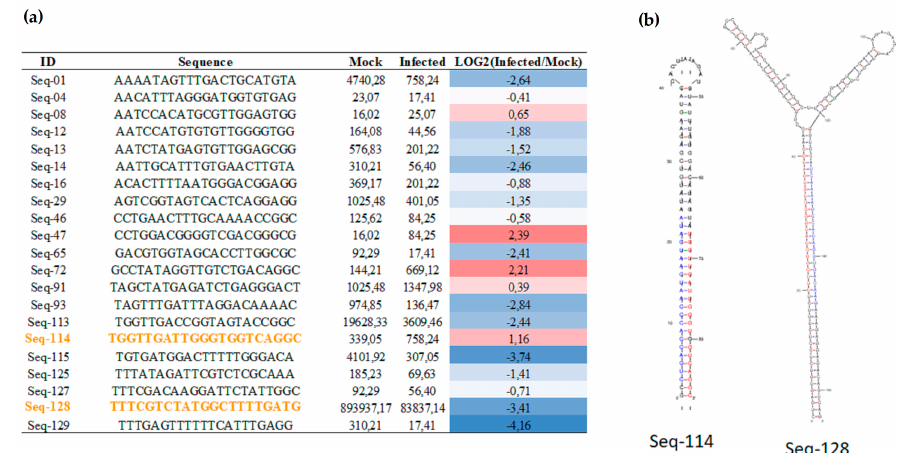
Figure 3. Novel miRNA present in both libraries. ( a ) Differential expression levels of novel miRNAs with more than 25 raw reads present in both libraries. The raw numbers were normalized to reads per million and compared between libraries from mock and infected plants. The log2 transformation counts were performed in the infected/mock comparisons. The heatmap showed miRNAs to be downregulated (blue) and upregulated (red) in response to pathogenic infection. Novel miRNA that have miRNA* in the same library were highlighted by orange letters; ( b ) Bona fide precursors; mature miRNAs (red) and miRNA* (blue).